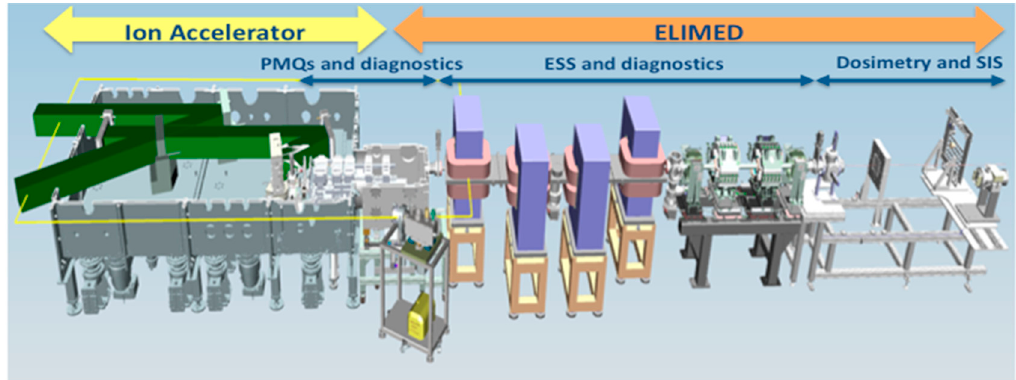
Figure 1. The main sections of the ELI multidisciplinary applications of laser-ion acceleration (ELIMAIA) beamline (ion accelerator and ELI medical and multidisciplinary applications (ELIMED)) consist of different subsystems: acceleration, collection, and diagnostics; selection, transport, and diagnostics; and dosimetry and sample irradiation [9].